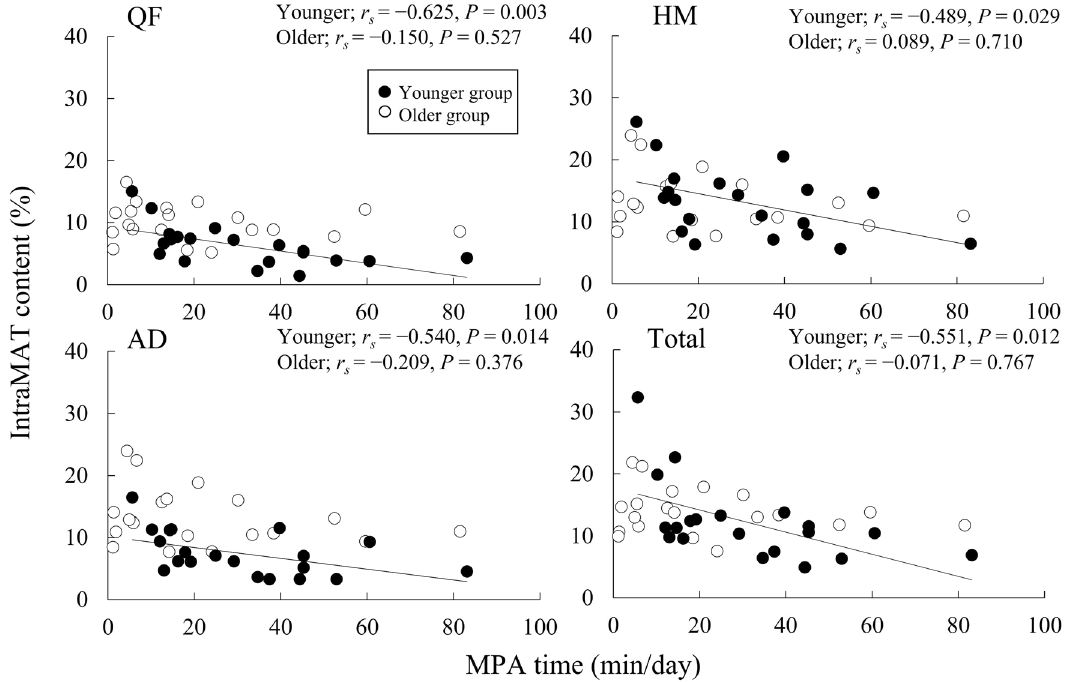
Figure 2. Correlation between moderate-intensity physical activity (MPA) times and intramuscular adipose tissue (IntraMAT) content in younger and older men. QF quadriceps femoris, AD hip adductors, and HM hamstrings.